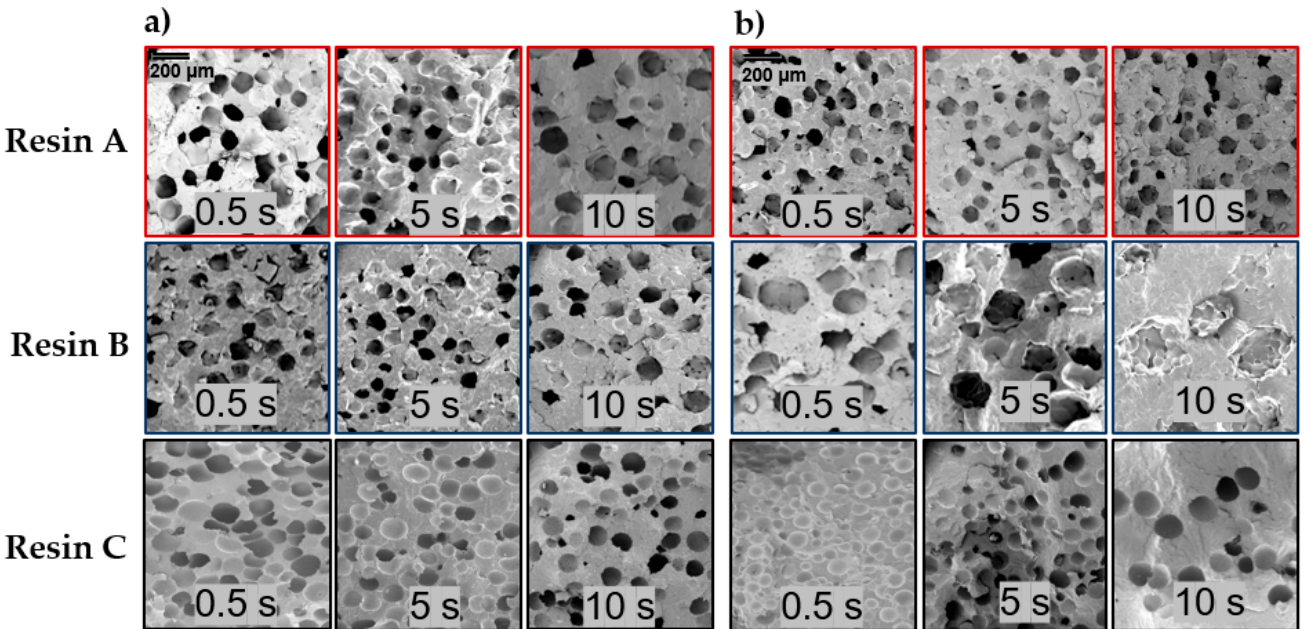
Figure 4. SEM image comparison of cellular morphology for Resins A, B, and C when foamed with ( a ) 2 wt% AV CBA and ( b ) 2 wt% UC CBA at different packing times (0.5, 5, and 10 s).